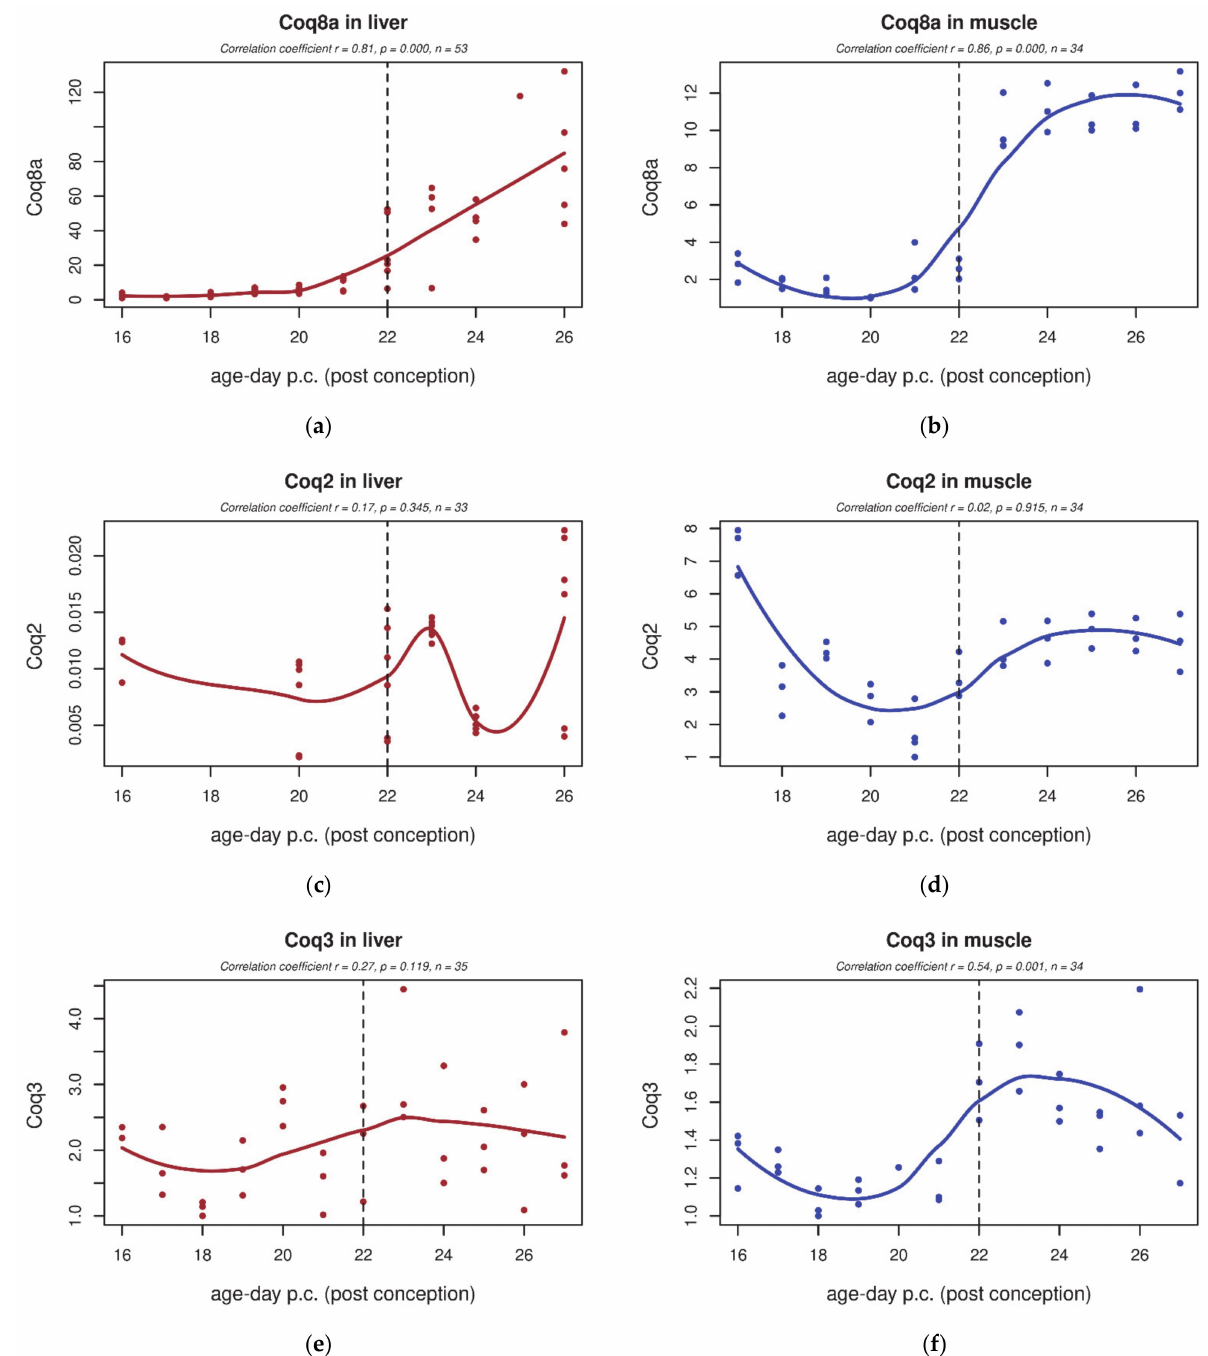
Figure 7. Coq8a , Coq2 , and Coq3 expression in rat tissues during early development. ( a , c , e ) In the rat liver, we detected significantly increased Coq8a transcripts after birth. Coq2 and Coq3 were unchanged ( c , e ). ( b , d , f ) In skeletal muscle, postnatal Coq8a was significantly increased ( b ). Genes Coq2 and Coq3 did not show any significant trend during perinatal development. The dashed line indicates the last foetal